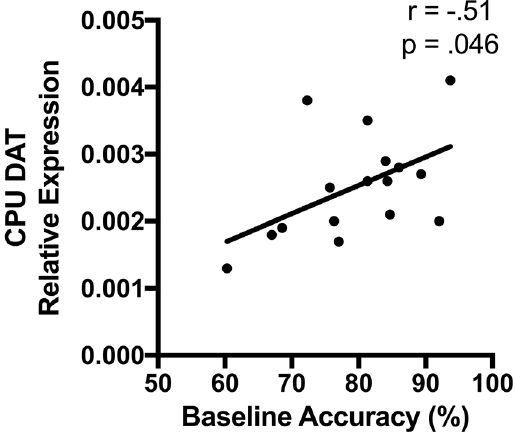
Figure 6. Dopamine transporter (DAT) gene expression in the striatum (CPU) was significantly correlated with baseline task performance such that low performing rats had reduced expression ( r = 0.506, p = 0.046, N =